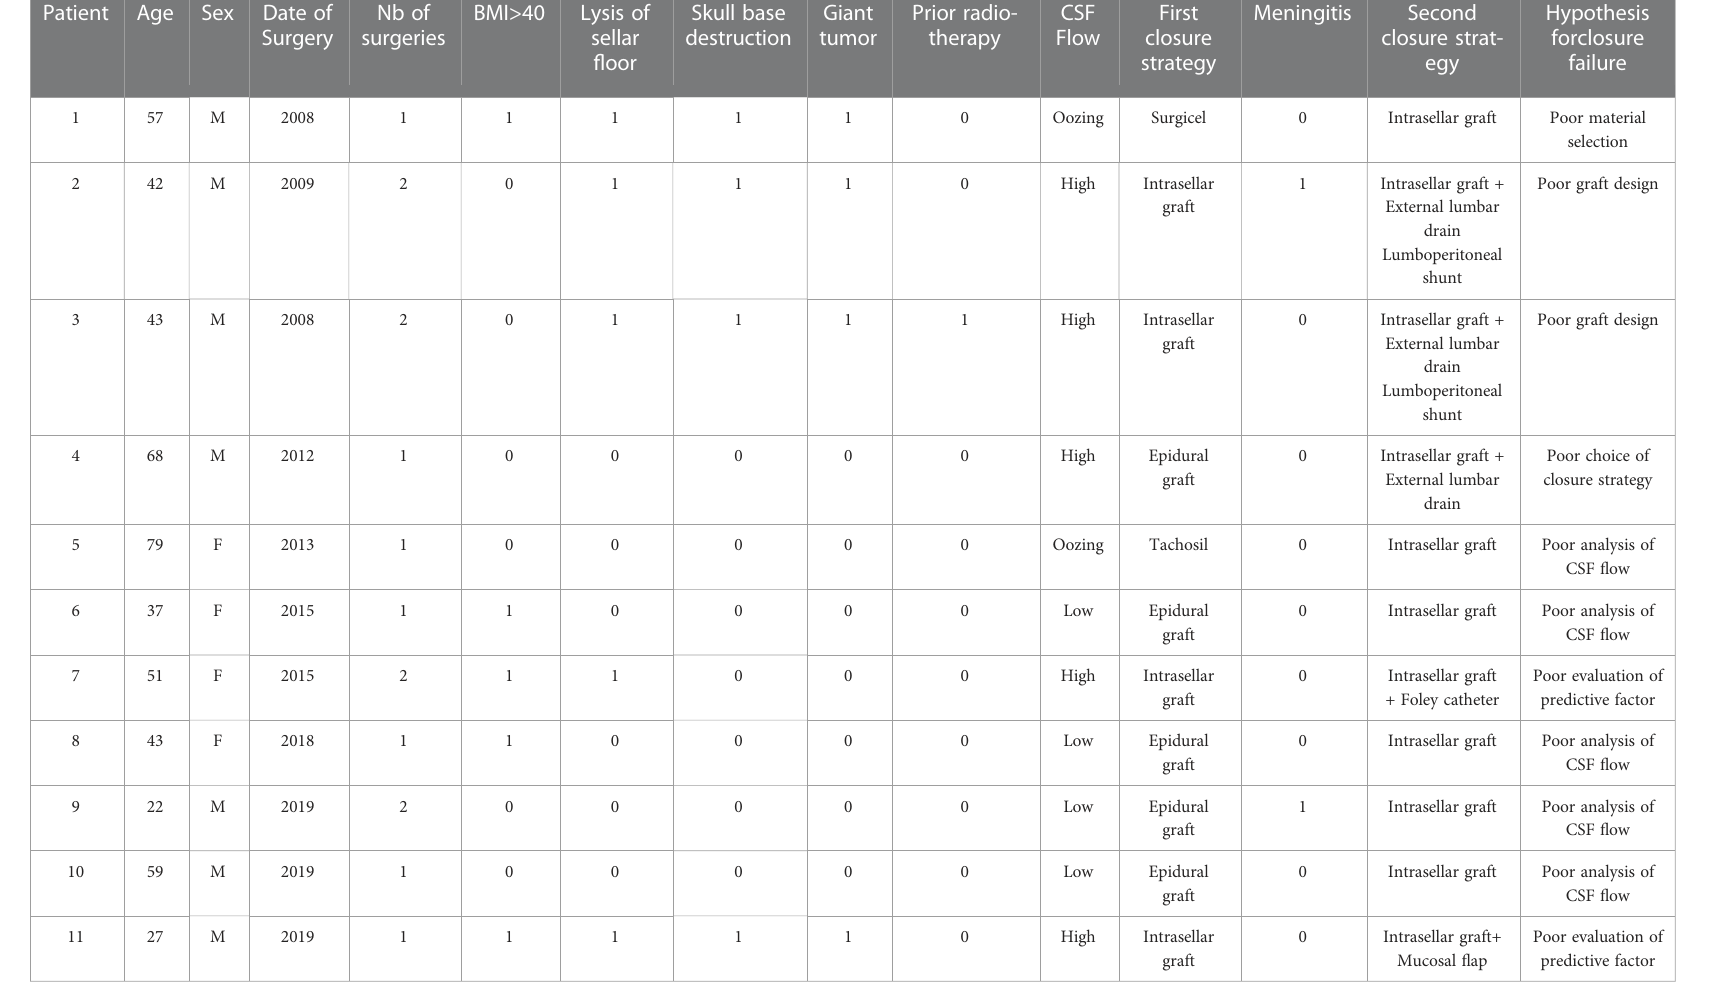
TABLE 2 Characteristics of the 11 patients with failed closure management despite a well-identi fi ed intraoperative CSF leak.